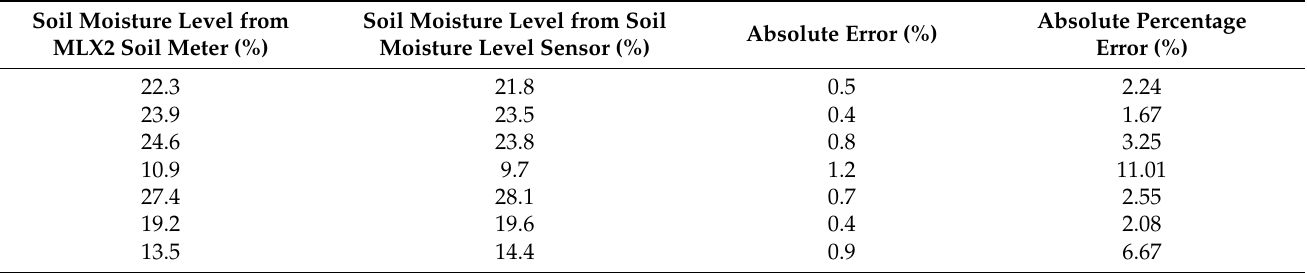
Table 2. Comparison of soil moisture level between MLX2 soil meter and the soil moisture level